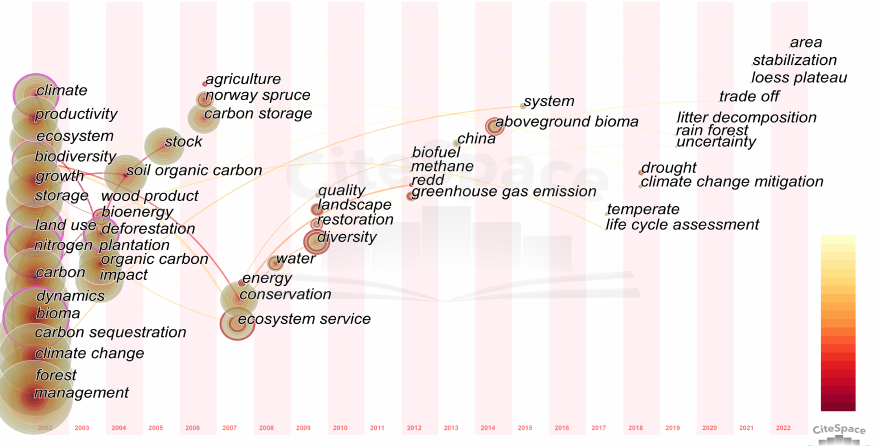
Figure 12. Research keyword time zone view